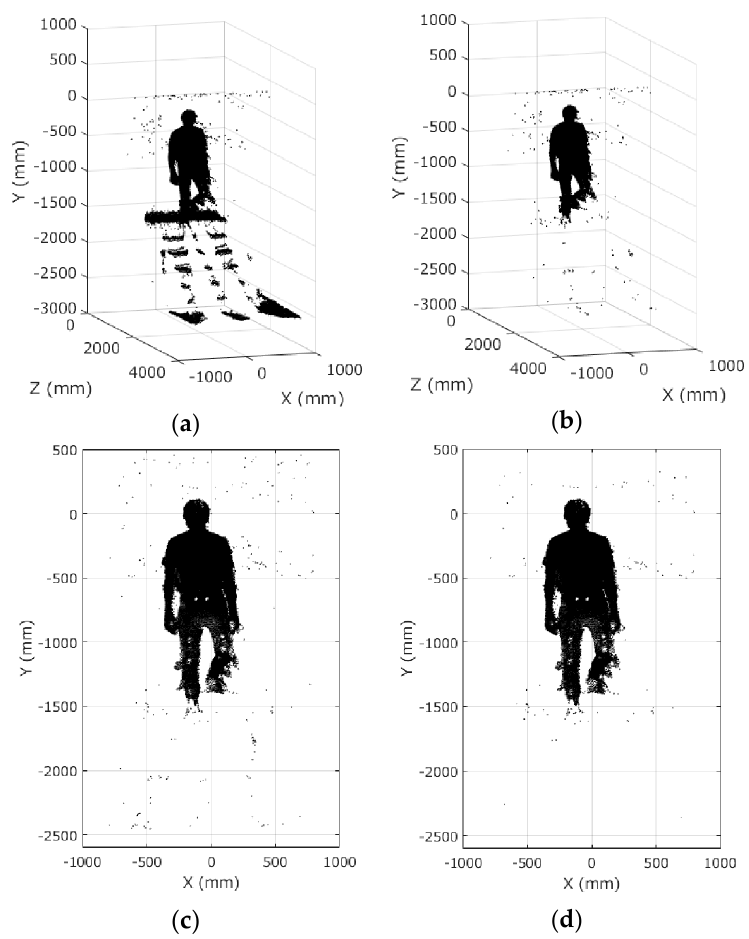
Figure 6. Background elimination and noise rejection: ( a ) before background elimination; ( b ) after background elimination; ( c ) after background elimination and before noise rejection; ( d ) after noise rejection.